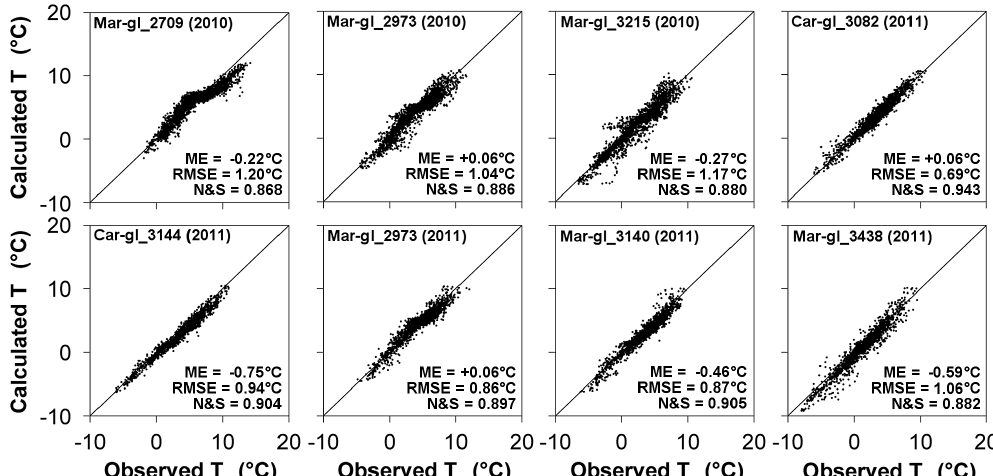
Figure 9. On-glacier temperature calculated with the G&B method vs. observed